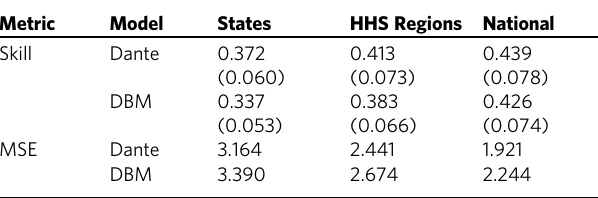
Dante and DBM average forecast skill and mean squared error (MSE) comparisons across geographic scales. For skill results both the FluSight challenge ’ s forecast skill and the exponentiated, proper log score are reported, with the proper skill in parentheses. Forecast skill and MSE each improve for both models as the geographic scale coarsens. Dante outperformed DBM at all geographic scales under both performance